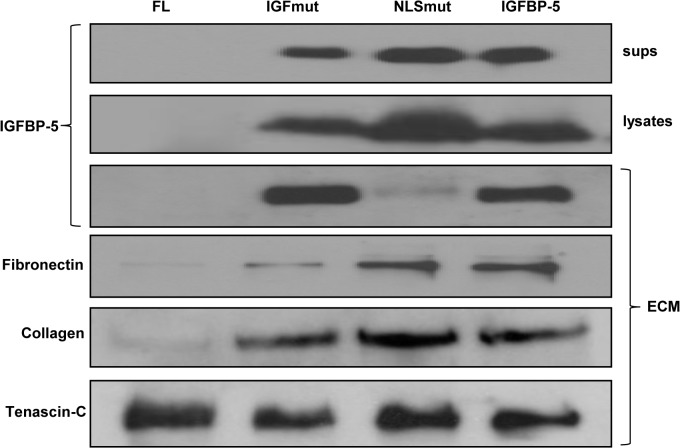
Mutant IGFBP-5 exerts in vitro pro-fibrotic activity that is similar to that of wild-type IGFBP-5.Primary human fibroblasts were infected with adenovirus expressing wild type IGFBP-5, IGF binding site-mutant IGFBP-5, or NLS-mutant IGFBP-5. Cell culture supernatants (sups), cellular (lysates), and extracellular (ECM) fractions were analyzed by immunoblotting.